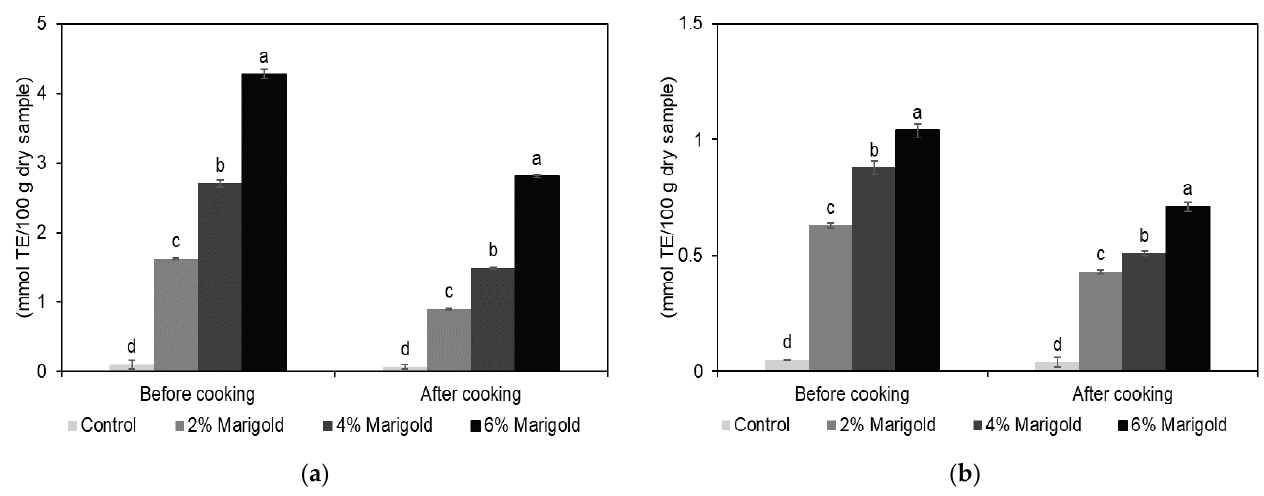
Figure 6. The antioxidant activities of the noodles prepared with marigold powder before and after cooking (DPPH ( a ) and ABTS ( b )) (means with different letters on the bars differ significantly at p < 0.05).